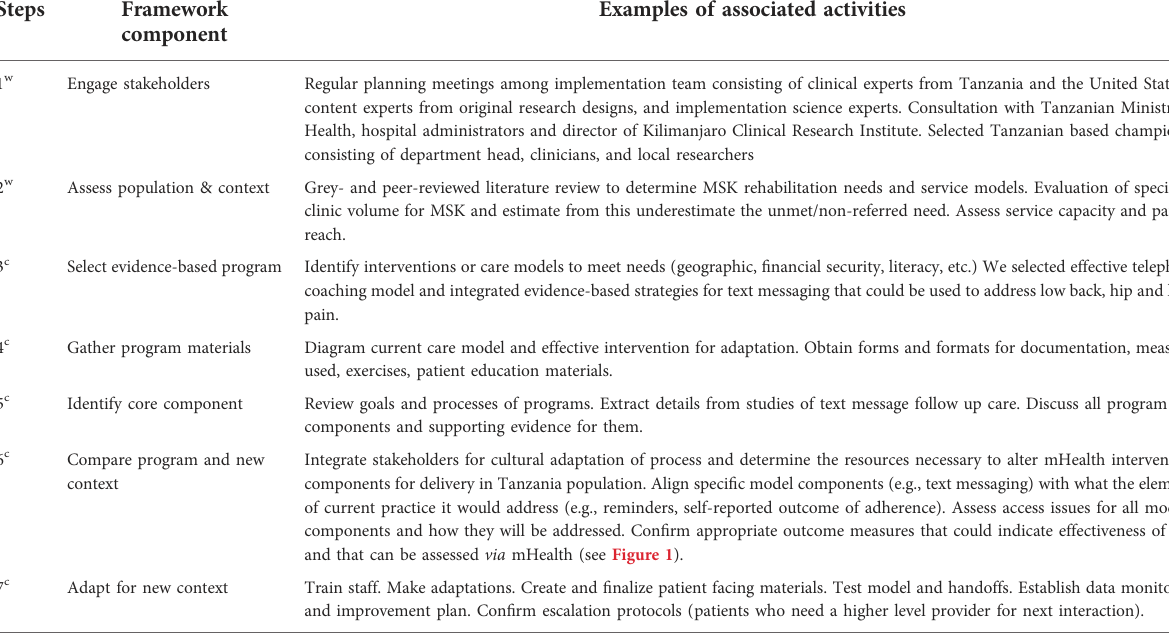
TABLE 1 Process for cultural w and contextual c adaptation of evidence-based MSK rehabilitation care interventions. Framework